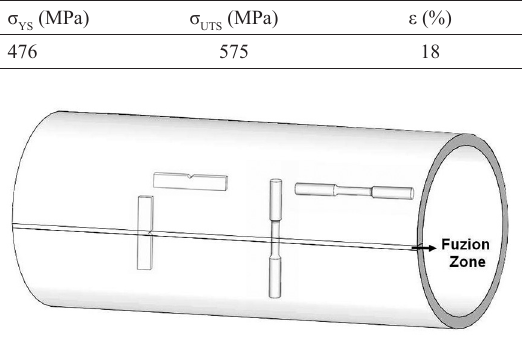
Figure 1: Location of tensile and CVN impact specimens in API 5L X65 pipe.